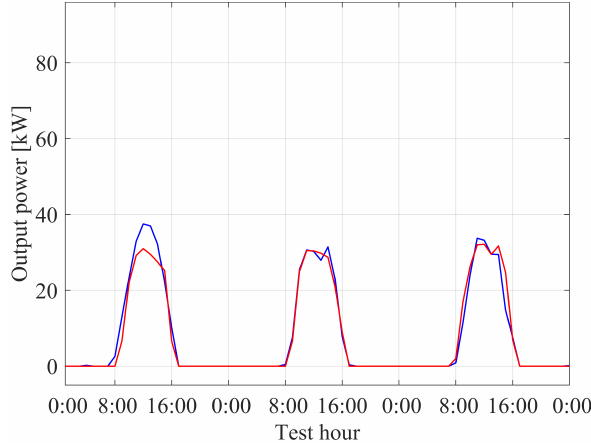
Figure 10. Predicted (red) and real (blue) value of output power in the mid of December 2018, by using the 2D-CNN approach with the combination of all the time series, which is also associated with the best performance on the 3-day test set (see Table 9, row 18, column 2).